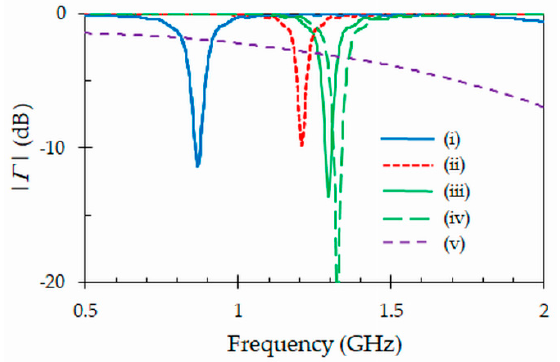
Figure 5. Simulated generalized reflection coefficients of the optimized tag antenna in five different scenarios: (i) tag attached to a tube full of blood, (ii) tag attached to an empty tube, (iii) tag removed from the tube but keeping its initial curvature, (iv) tag removed from the tube and unfolded, and (v) tag unfolded and attached to a bag full of blood.